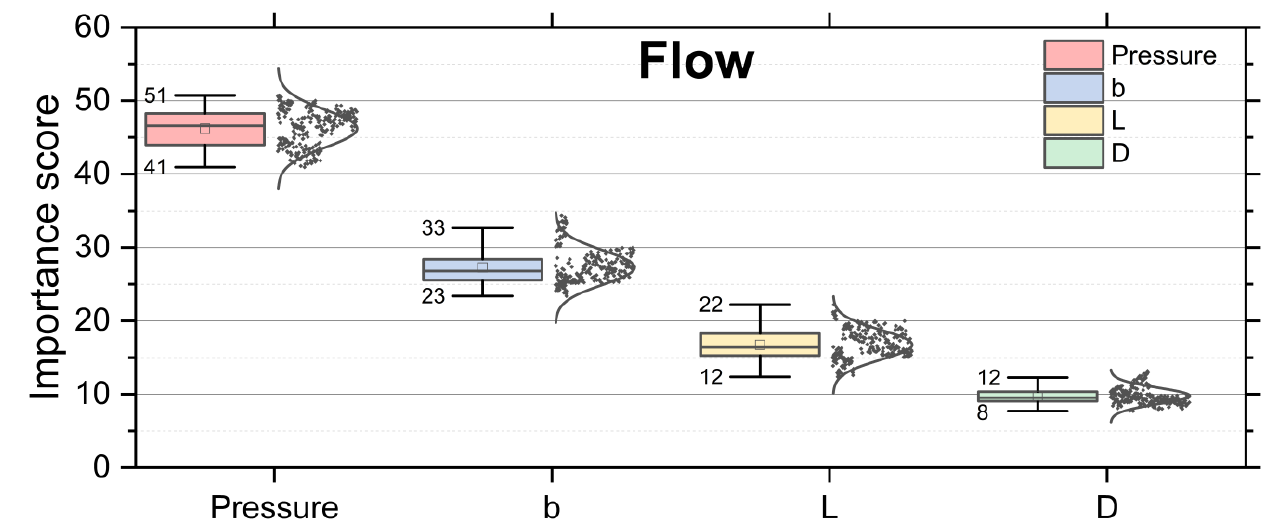
Figure 13. Importance scores of the input variables for the emitter flow rate prediction model.